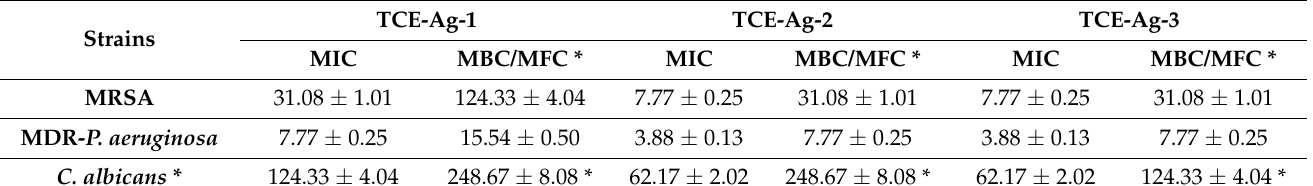
Table 3. MIC and MBC/MFC * ( µ g/mL) values of TCE-AgNPs against test strains of bacteria and fungi (* indicate MFC for C. albicans ).